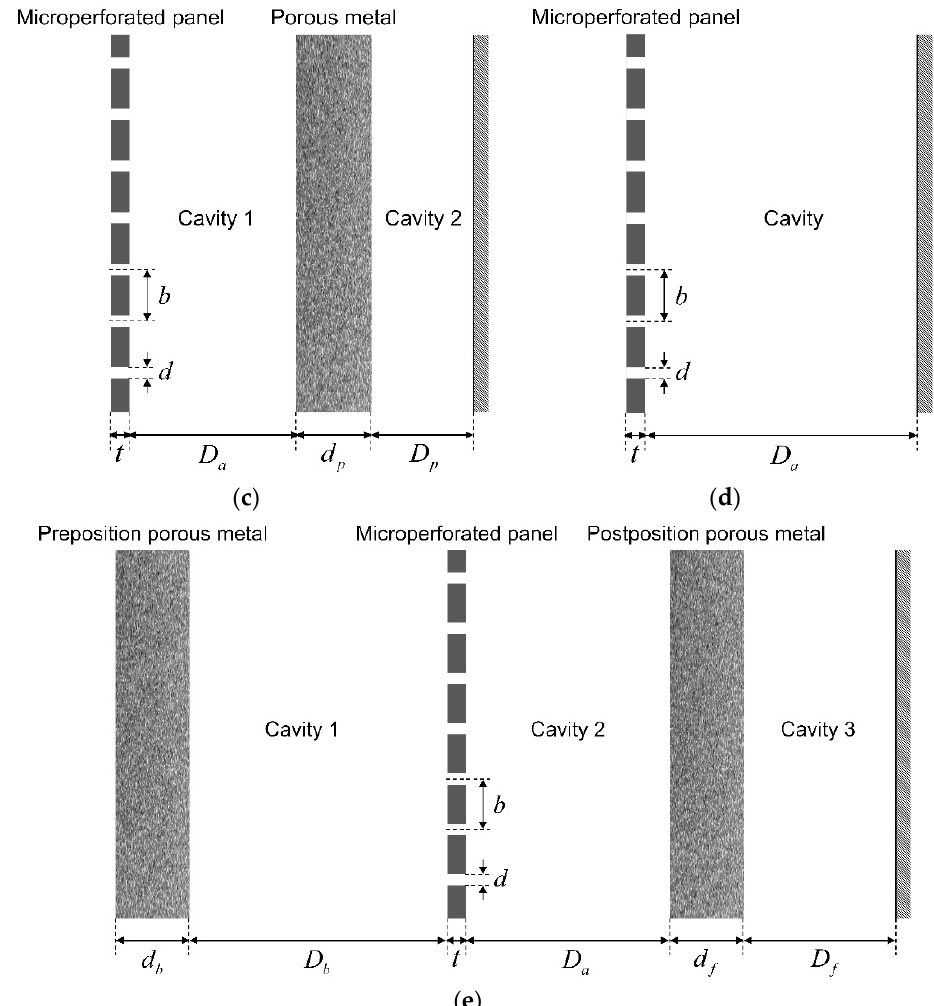
Figure 1. Schematic diagrams of the investigated composite structures and corresponding labels of their structural parameters. ( a ) porous metal + cavity + microperforated panel + cavity (PCMC); ( b ) porous metal + cavity (PC); ( c ) microperforated panel + cavity + porous metal + cavity (MCPC); ( d ) microperforated panel + cavity (MC); ( e ) porous metal + cavity + microperforated panel + cavity + porous metal + cavity (PCMCPC).